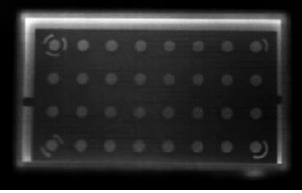
Figure 3. Thermal imagery for calibration